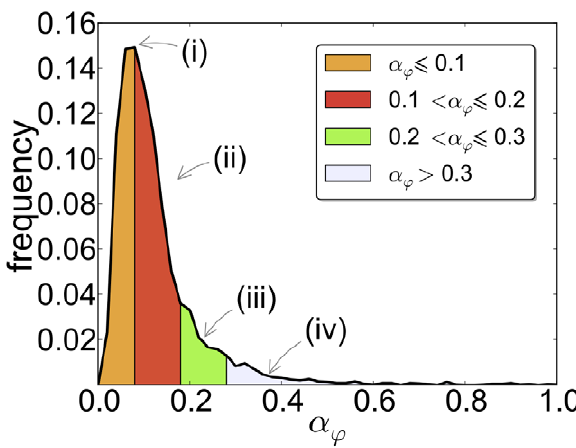
Figure 2. Distribution of the estimated initiation rates in S. cerevisiae . The mean initiation rate is 0 : 12s { 1 and the median is 0 : 09s { 1 . Most of the mRNAs have an estimated initiation rate a Q v 1 and therefore we show only this range.